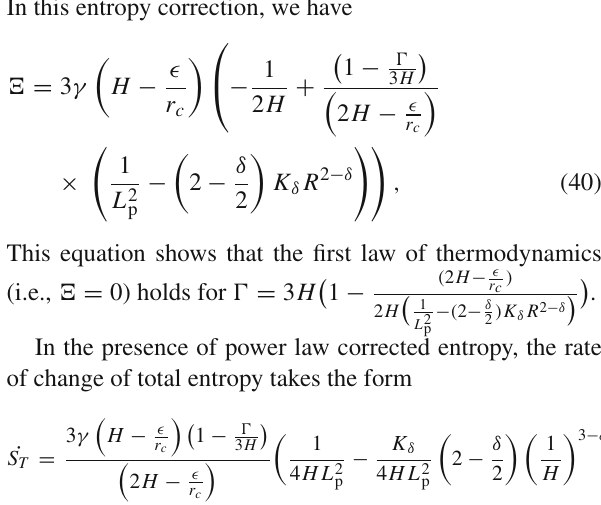
The plot of total entropy ( S T ) is shown in Fig. 7 versus γ for three values of T by assigning the constant values as L = 1, H = 67, 1 , α = − 2, and (cid:7) = − 1. We observe that total 67 entropy is positive, i.e, ( S T ) > 0 which leads to the validity of GSLT for all values of T